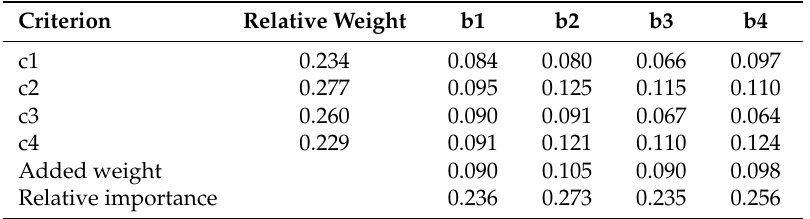
Table 18. Relationship matrix of organizational performance and project